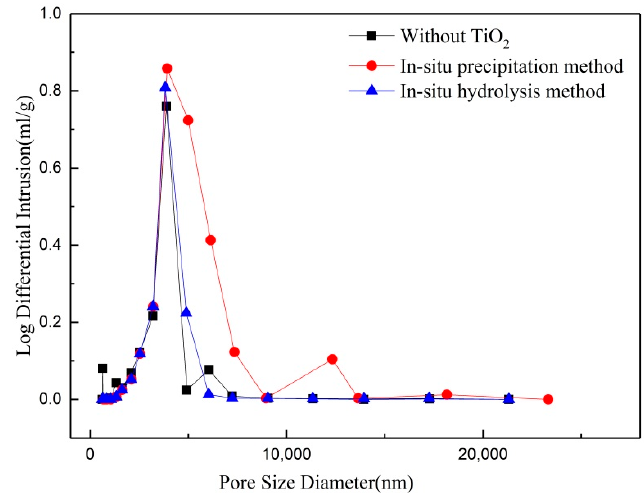
Figure 7. Pore size distributions of the supports with 0.6 wt.% TiO 2 added by in-situ precipitation and in-situ hydrolysis method.